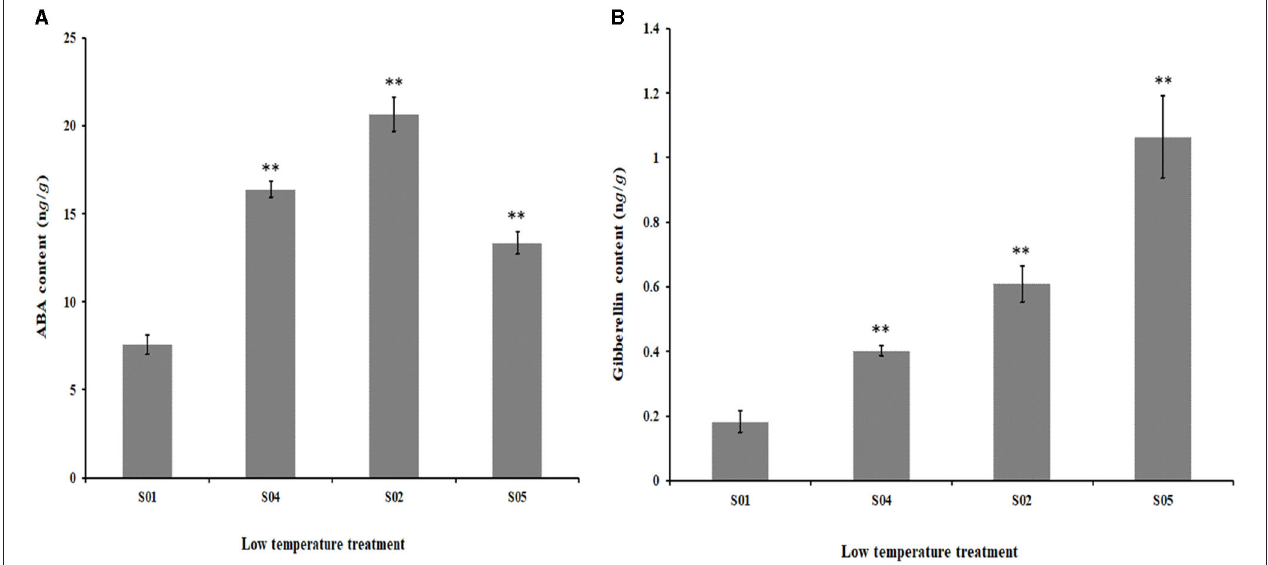
FIGURE 8 | The Abscisic Acid and Gibberellin contents in the potato plants during low temperature treatment. (A) The Abscisic Acid contents in the potato plants during low temperature treatment; (B) The Gibberellin contents in the potato plants during low temperature treatment. * P < 0.05; ** P < 0.01; the number of biological replicates =